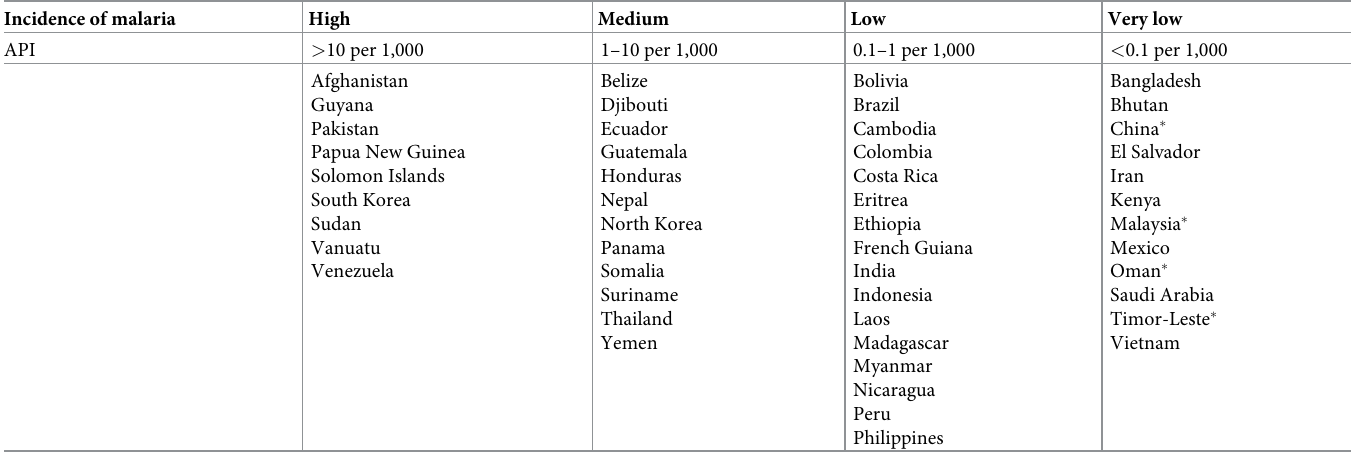
Table 2. National incidence of P . vivax malaria in 49 endemic